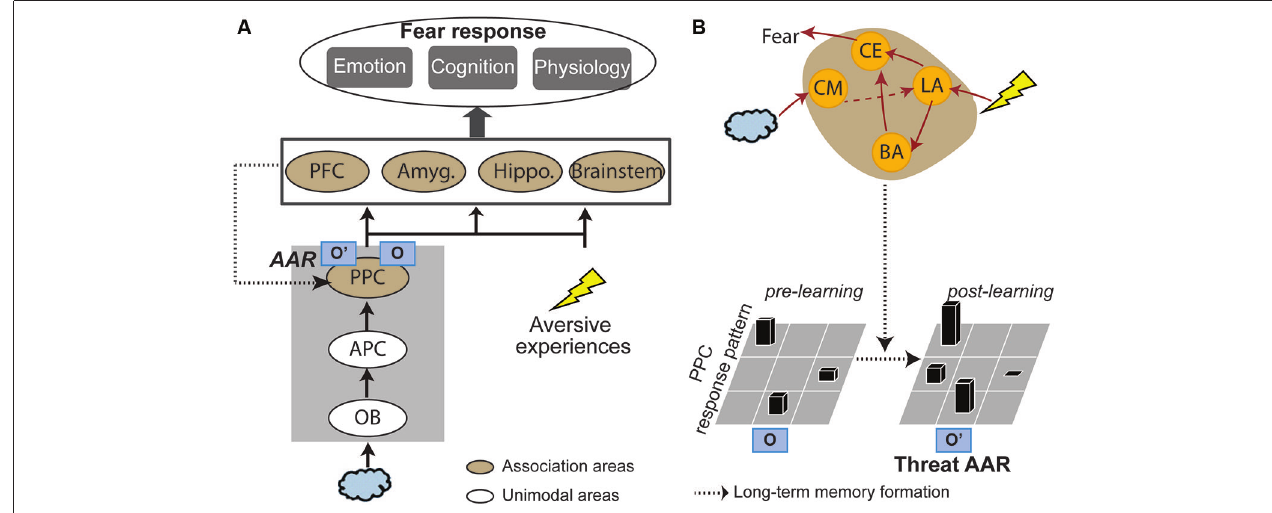
between the odor and aversive experience is formed in the lateral amygdala (LA), which projects directly or indirectly (via the basal nucleus of amygdala/BA) to the central nucleus (CE) to initiate and control fear responses. Over time, the acquired association is converted into a long-term memory stored in the PPC in the form of a threat AAR. Possible mediating mechanisms are increases in amygdala theta oscillation, cholinergic activity and amygdala efferents to the PPC. APC = anterior piriform cortex; OB = olfactory bulb; PFC = prefrontal cortex; Amyg. = amygdala; Hippo = hippocampus; CM = corticomedial nucleus of